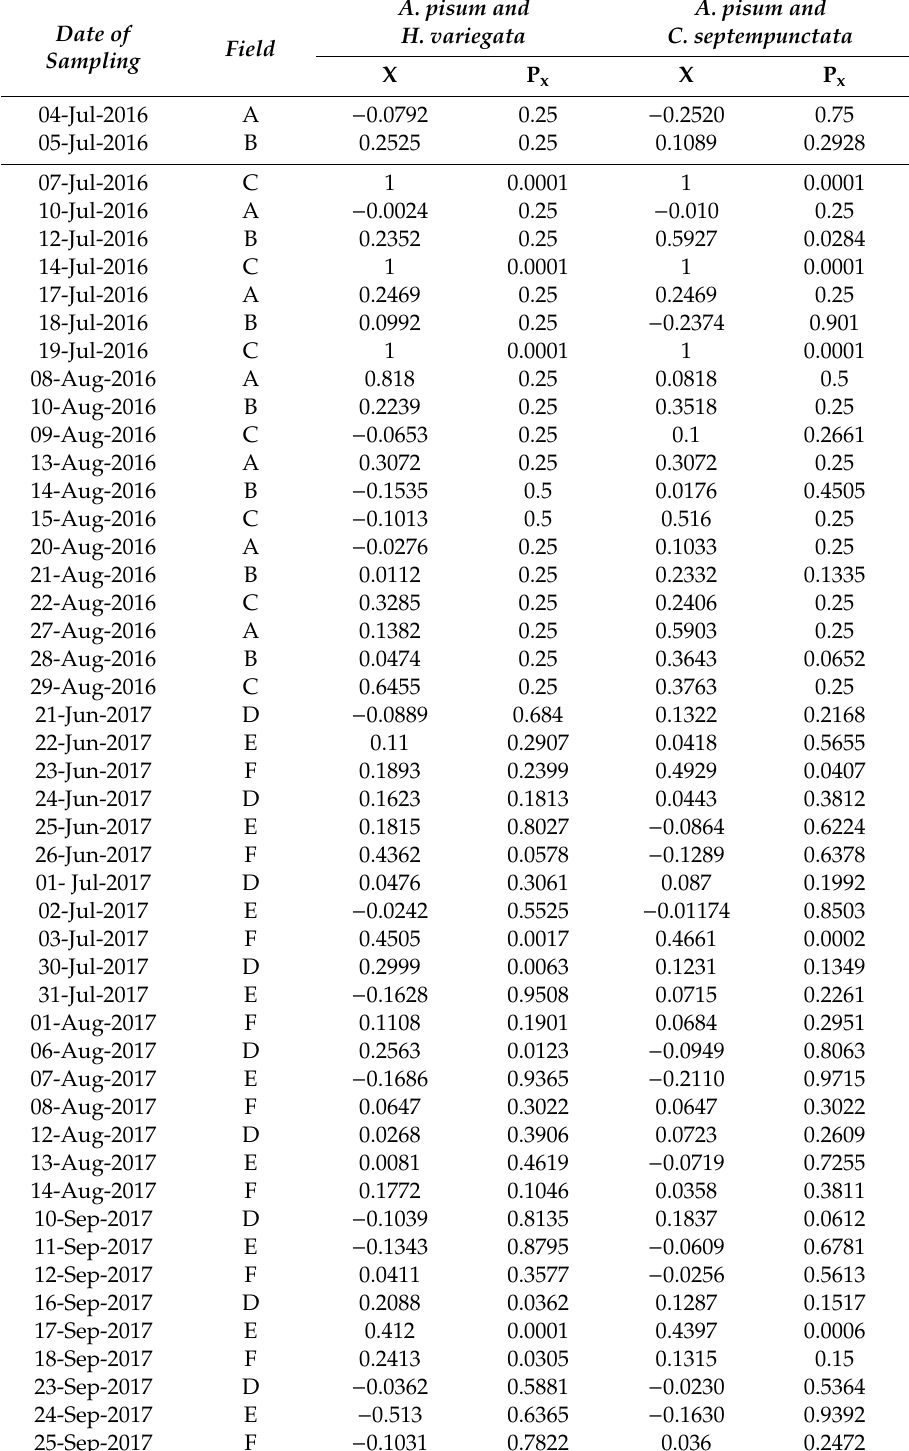
Table 4. Spatial association between Acyrthosiphon pisum and Coccinellids ( Coccinella septempunctata and Hippodamia variegata